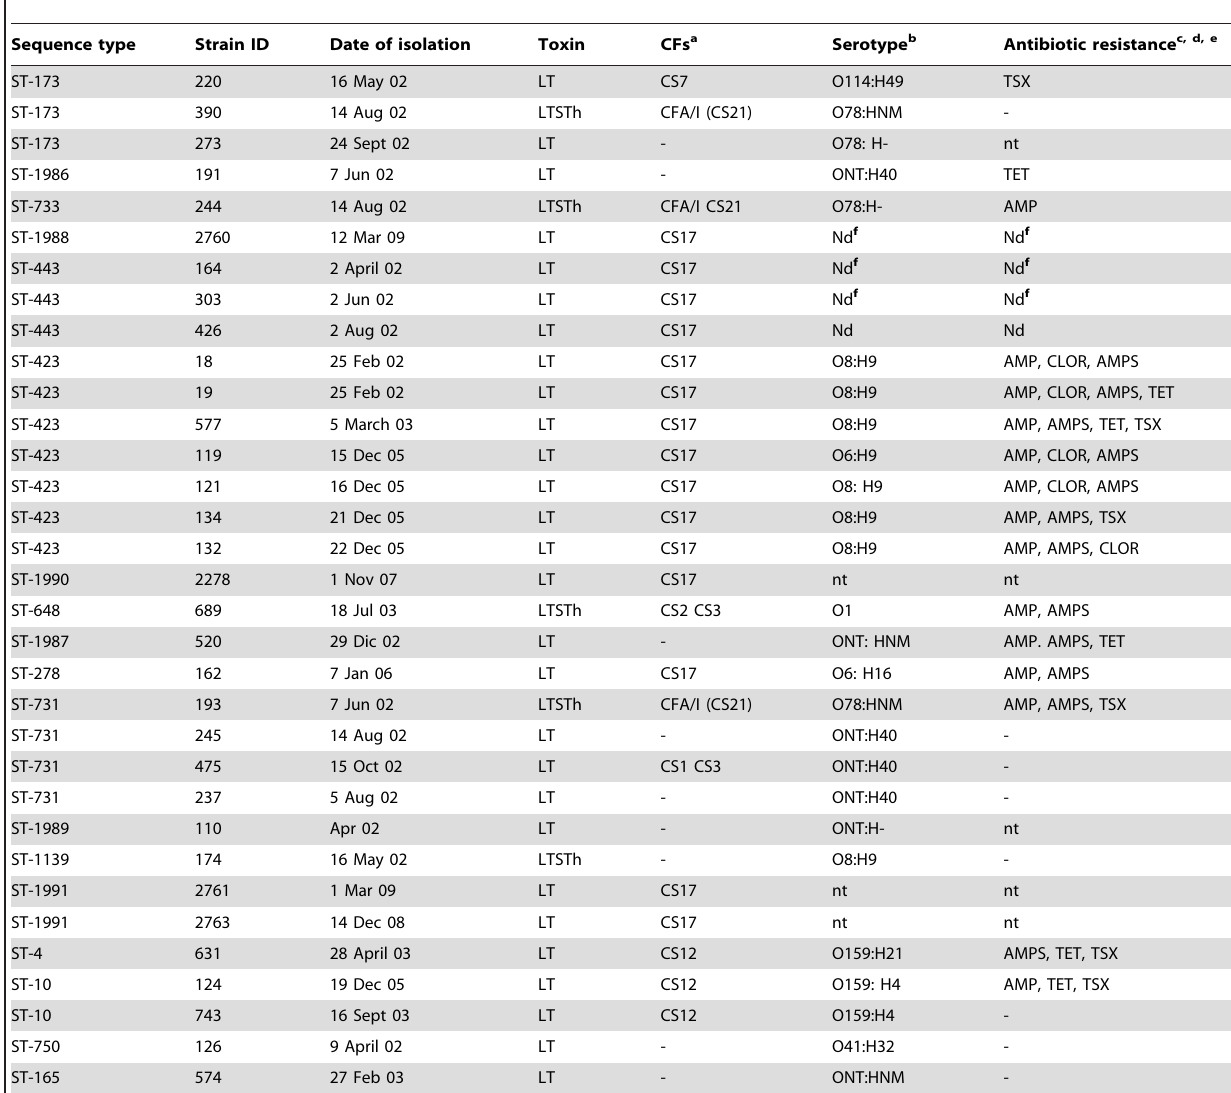
Table 2. Characterised ETEC strains collected from Bolivian children with diarrhoea 2002–2009 organised with respect to genetic distance according to the MLST analysis and time of isolation within each sequence